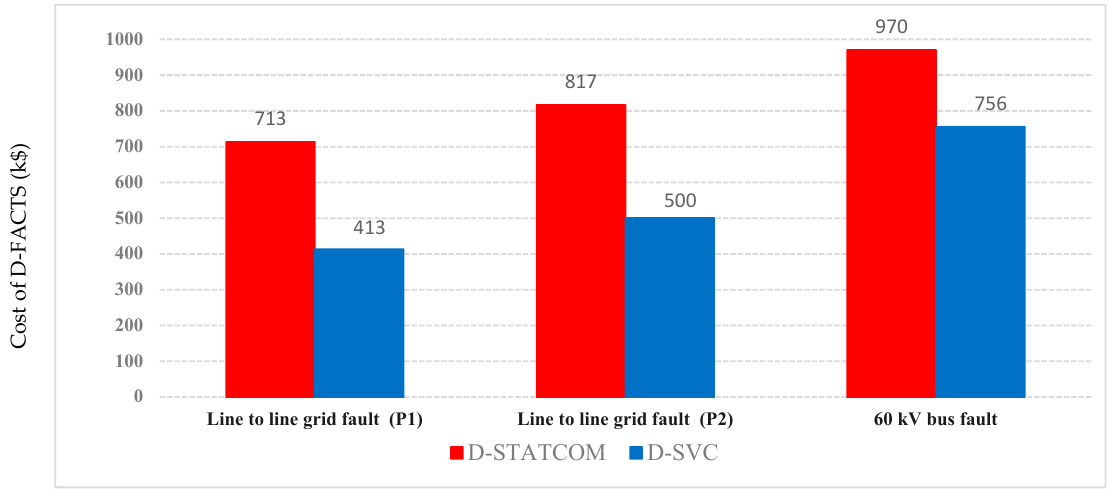
Figure 21. Cost of D-FACTS systems from different types of grid faults.